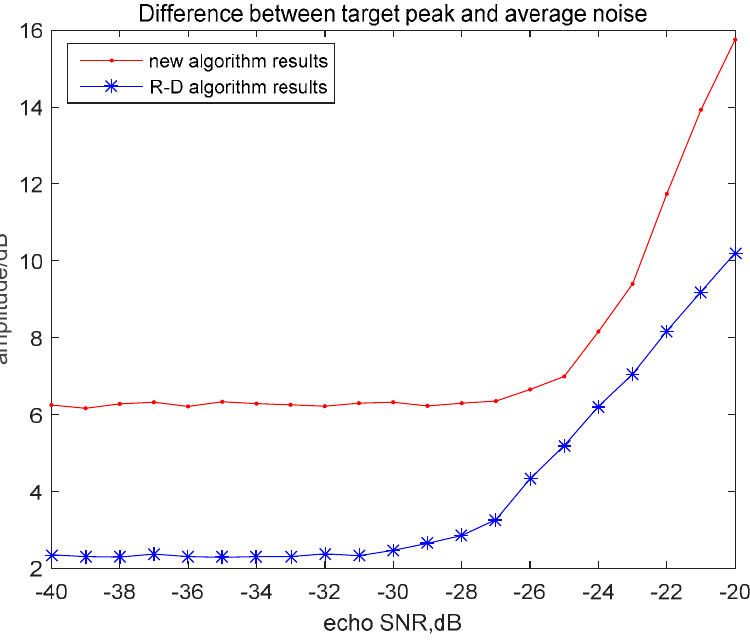
Figure 10. Difference between the target peak and the average noise platform ( N = 10 4 ).